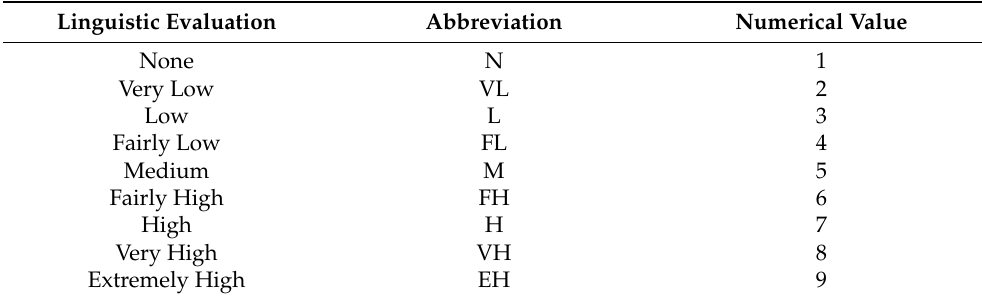
Table 1. Evaluation scale.